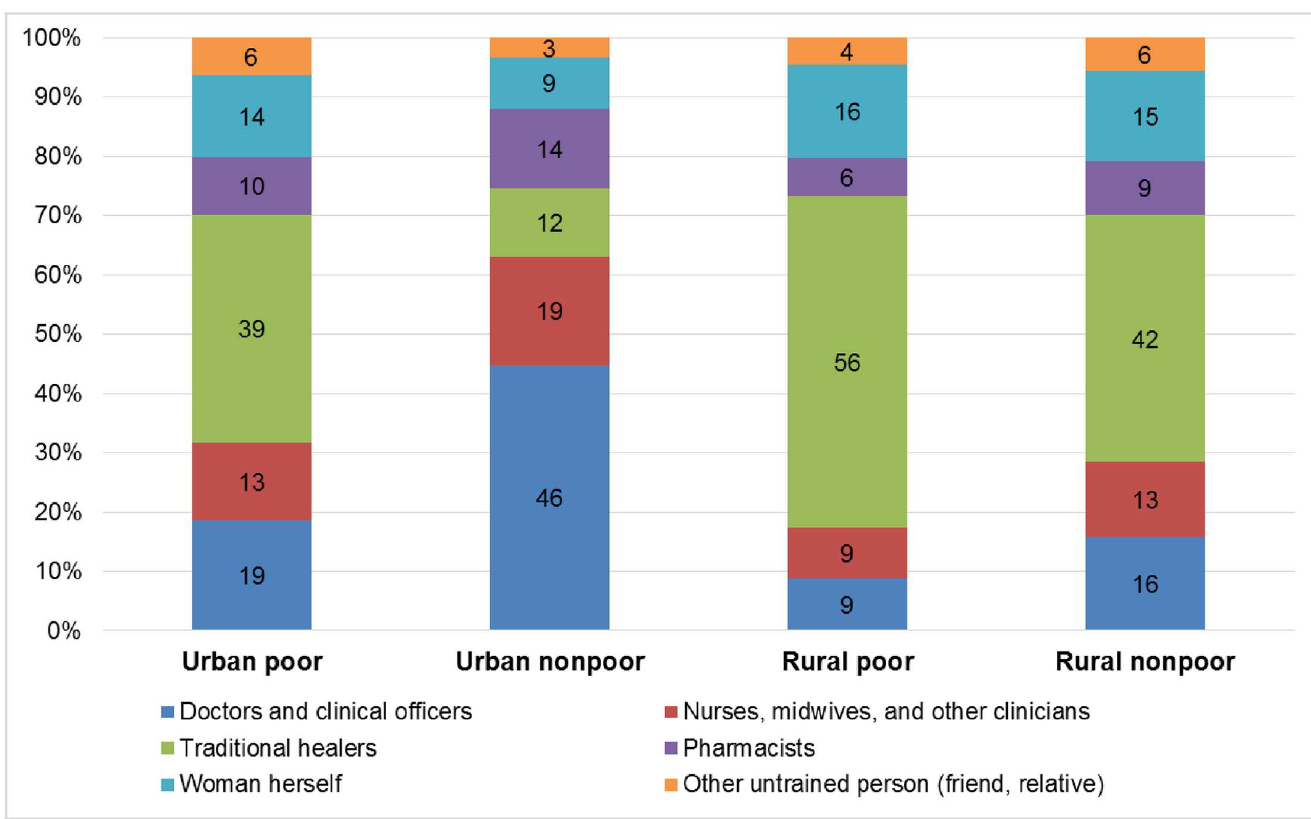
Fig 1. Abortion procurement by provider type, according to women’s sociodemographic characteristics, Knowledgeable Informant Survey, Malawi 2015.